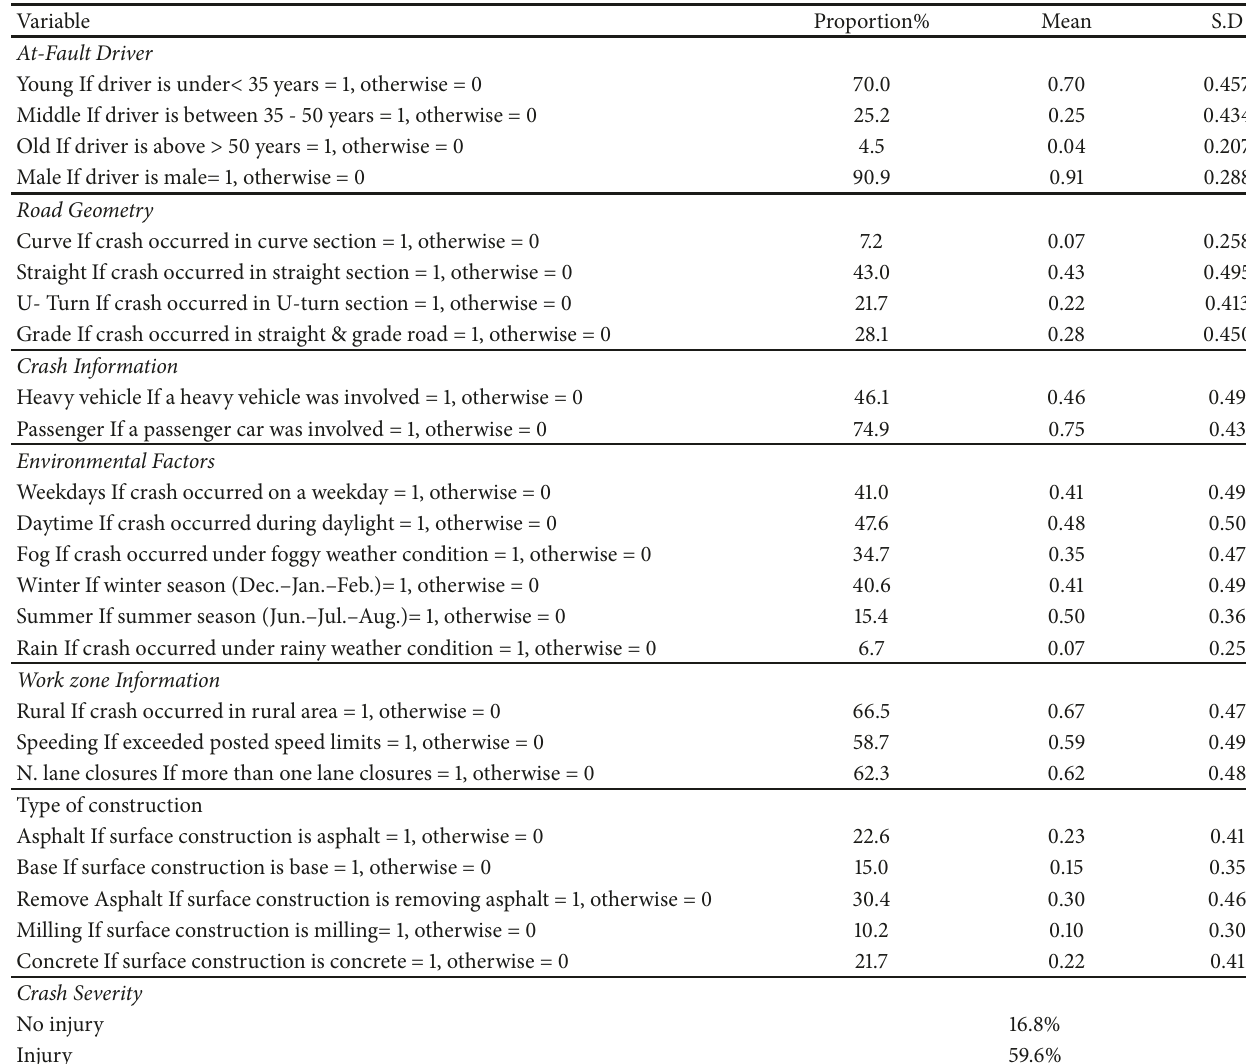
Table 1: Summary of descriptive